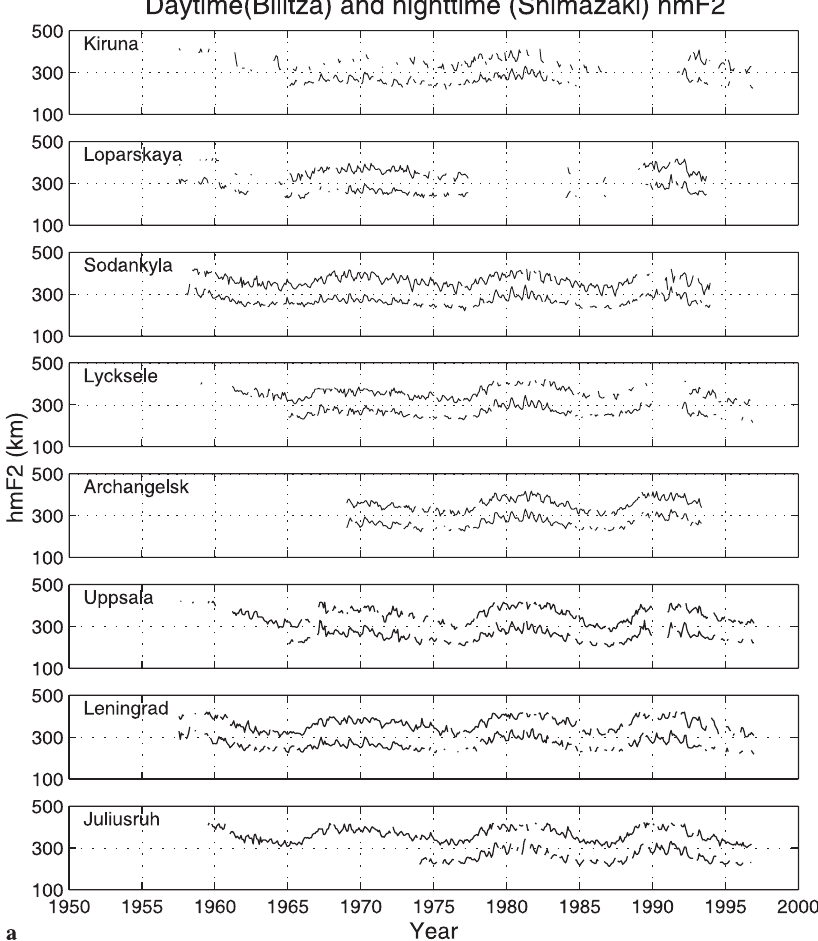
Fig. 2a, b. Time sequences of day (10–14 LT) ( lower curve in each box ) and night (22–02 LT) ( upper curve in each box ) values of h mF2, computed from tabulated MUF factors derived from ionograms, using monthly values for 16 stations arranged in order of decreasing magnetic latitude. a Kiruna to Juliusruh; b Slough